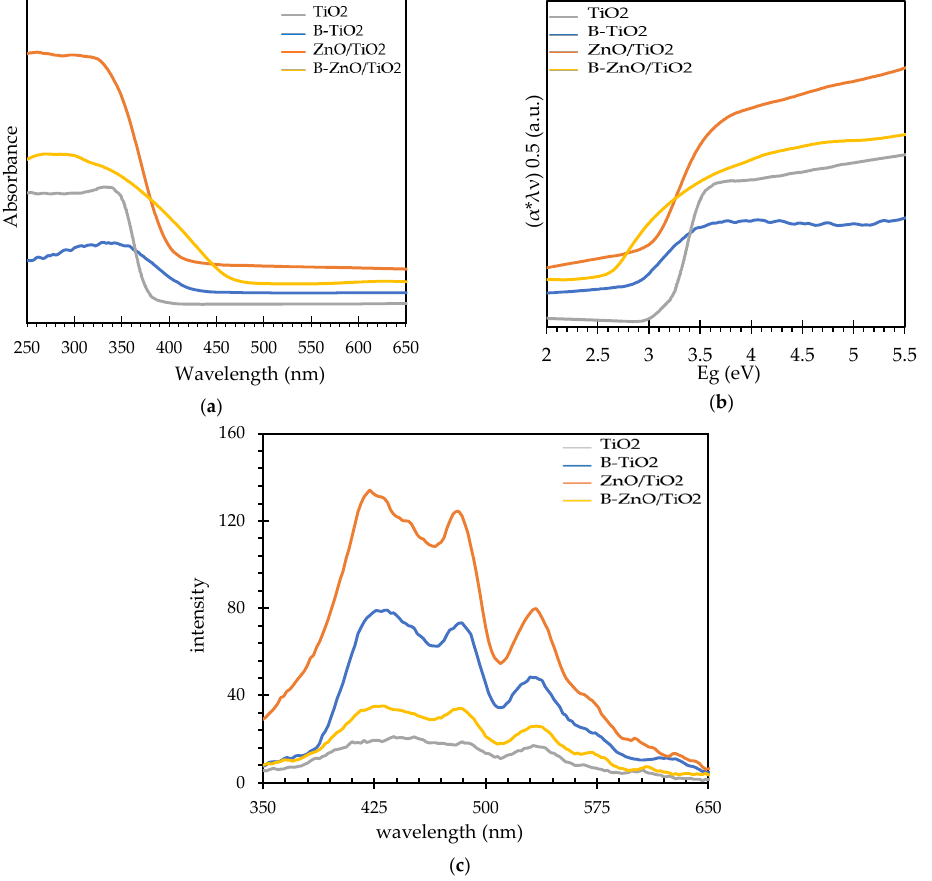
Figure 5. ( a ) DRS spectra, ( b ) Tauc plots, and ( c ) PL analysis for pure TiO 2 , B-TiO 2 , ZnO/TiO 2 , and B-ZnO/TiO 2. Moreover, the PL signal was used to investigate the lifetime and separation of charge carriers. Figure 5c represents PL spectra of pure TiO 2 , B-TiO 2 , ZnO/TiO 2 , and B-ZnO/TiO 2 photocatalysts. The spectra of the TiO 2 , B-TiO 2 , and B-ZnO/TiO 2 show three peaks in the visible area, at 426, 484, and 534 nm, respectively, while that of ZnO/TiO 2 shows a peak at 534 nm. The peak at 426 nm (2.89 eV) is attributed to the relaxation of self-trapped excites localized on the TiO 6 octahedral [22,23]. According to the PL spectrum, doping B into TiO 2 had no positive effect on the PL spectrum ’s shape and peak intensity [33 - 36]. The overall decrease in PL intensity indicates a decreased recombination rate of the electron – hole pair under light irradiation [37]. The PL spectra of ZnO/TiO 2 and B- ZnO/TiO 2 indicate a decrease in peak intensity, which can be attributed to the immigration of photoinduced holes to the VB of ZnO [13]. The lower emission intensity peak for B-